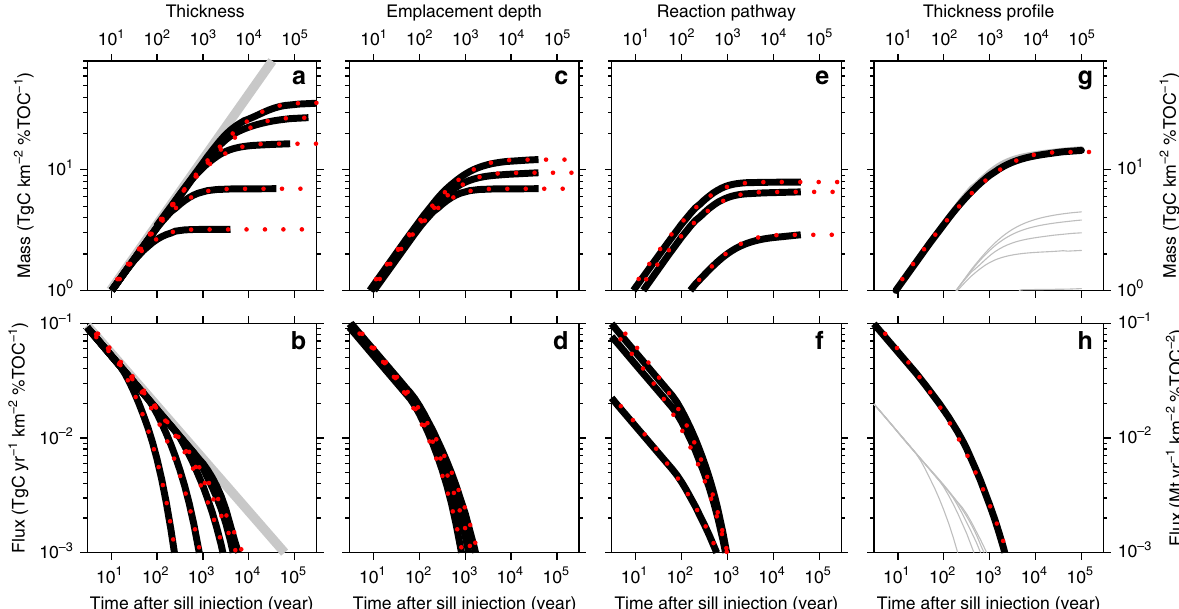
Fig. 3 Comparison between full carbon emissions modelling results and new carbon emissions parameterisation. Thick black lines represent full thermal and reaction kinetic modelling results; red dotted lines represent new parameterisation. a , b Mass and fl ux of carbon emissions from breakdown of labile kerogen for sills of thickness 50, 100, 200, 300 and 400 m, all intruded at 1 km depth. Thick grey line shows a power law with exponent p = 0.54 for reference; all calculations in this fi gure assume a constant host-rock density of 2100 kg m − 3 , appropriate for the mean emplacement depth (1.2 km), in order to illustrate the consistent tapered power-law behaviour of emissions. c , d Mass and fl ux of emissions from breakdown of labile kerogen for sills intruded 1, 2 and 3 km deep, all 100 m thick. e , f Mass and fl ux of emissions for a 100-m-thick sill intruded 2 km deep from three reaction pathways: breakdown of refractory kerogen; breakdown of labile kerogen to oil and then cracking of oil to gas; and direct from labile kerogen. g , h Modelling of emissions for a sill of variable thickness pro fi le. A radially symmetrical sill with maximum thickness 200 m and intruded 2 km deep is divided into fi ve annuli of equal surface area. The thickness of each annulus is prescribed by the radial thickness pro fi le parameterisation in Fig. 2. Emissions from these fi ve annuli (thin grey lines) are summed to estimate the total (thick black